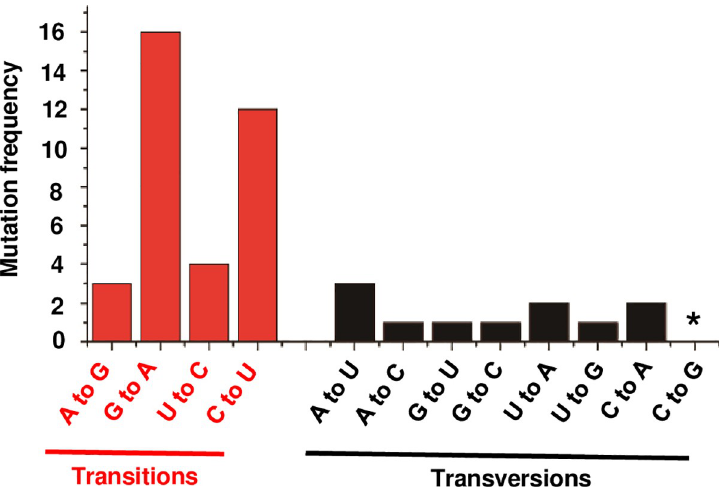
Fig 4. Base substitutions introduced by Pol II in PSTVd. Mutations were mapped to genomic (+)-strand PSTVd. Number of transition and transversion events observed by dimer sequencing across all three biological replicates are shown. Asterisk indicates none observed.